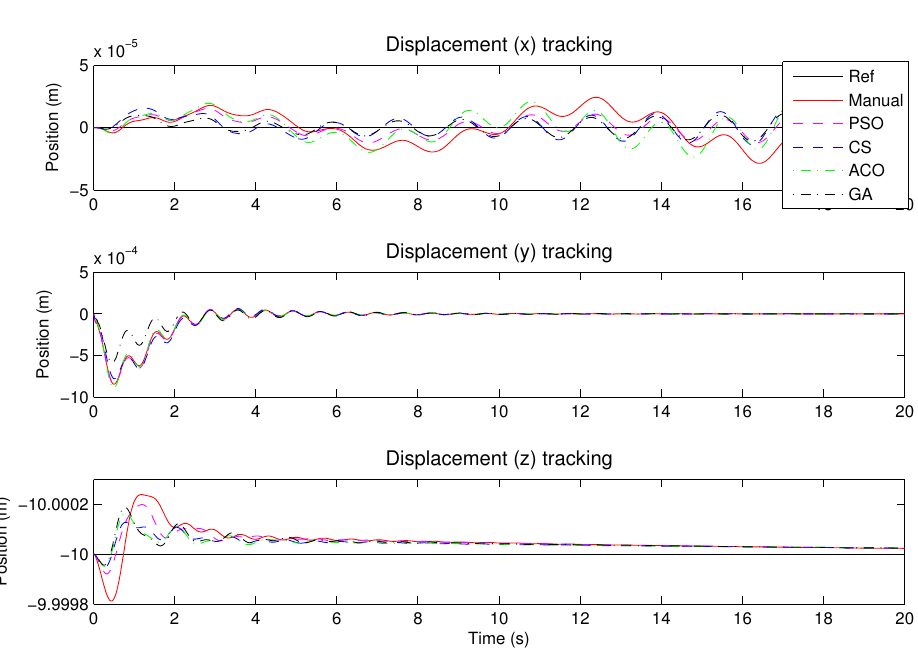
Figure 7. The controlled nonlinear rotorcraft position response to selected desired inputs.